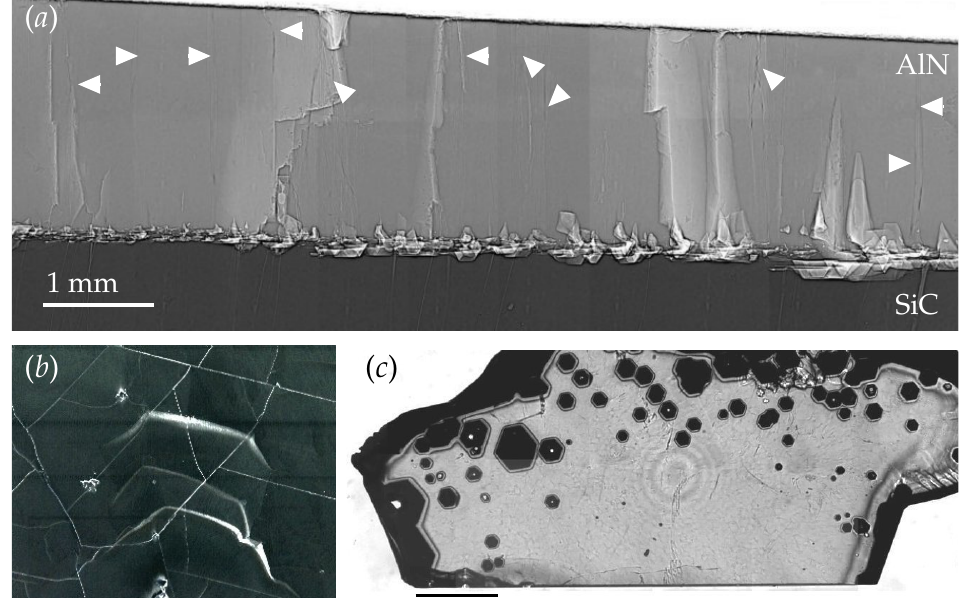
Figure 2. ( a ) Synchrotron X-ray phase contrast image of AlN/SiC template in cross section view. White arrows highlight the locations of cracks; ( b ) SEM image of AlN/SiC template in planar view. Field width 2 mm; ( c ) optical micrograph (in reflection light) of freestanding AlN layer. Scale bar 1